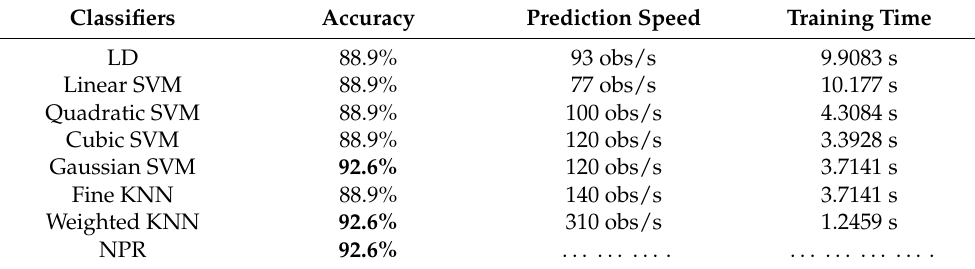
Table 4. Classification outcome information (men data).